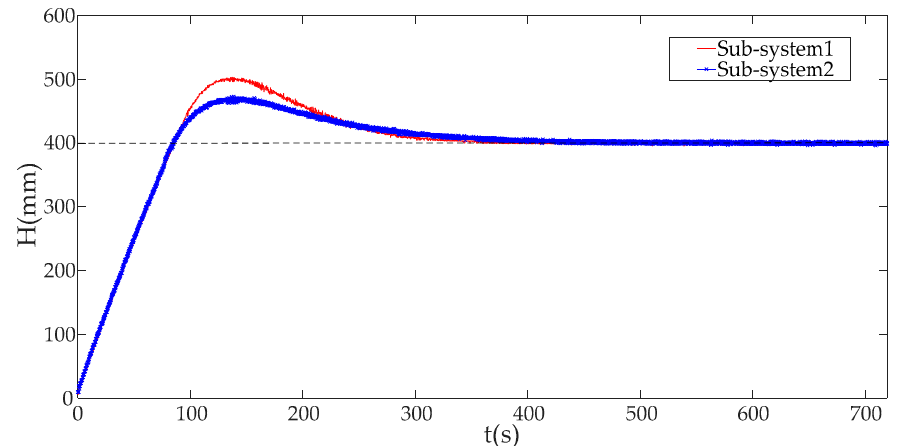
Figure 15. The system responses with different sub-system without DoS attack.